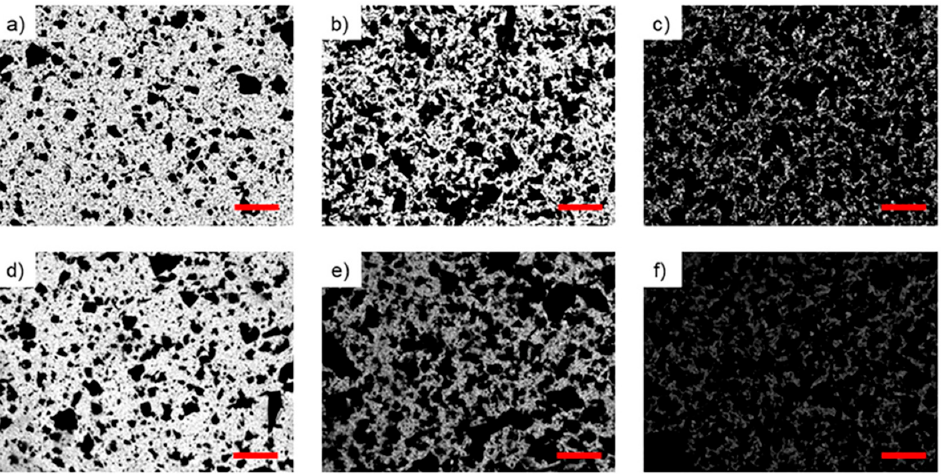
Figure 9. Optical images of nanocomposite samples fabricated by mold casting and cured at 50 ◦ C for 24 h. Top: PDMS ‐ based nanocomposites filled with ( a ) 1 wt%; ( b ) 3 wt%; and ( c ) 5 wt% of GNP–DNA. Bottom: PDMS/PDMS–OH ‐ based nanocomposites filled with ( d ) 1 wt%; ( e ) 3 wt%; and ( f ) 5 wt% of GNP–DNA. Scale bar: 1 mm.